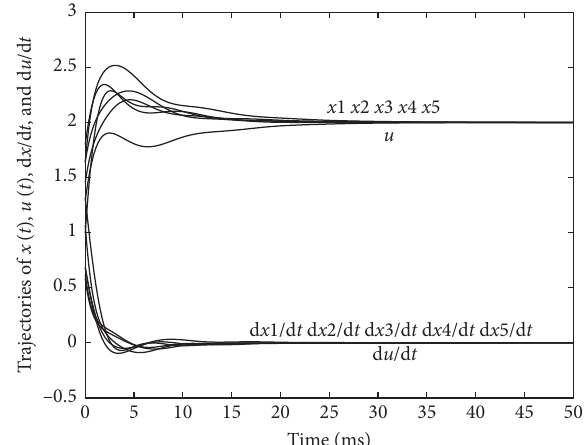
Figure 2: Transient behavior of x ( t ) and u ( t ) of the second-order differential equation system (16) in the example with ρ �